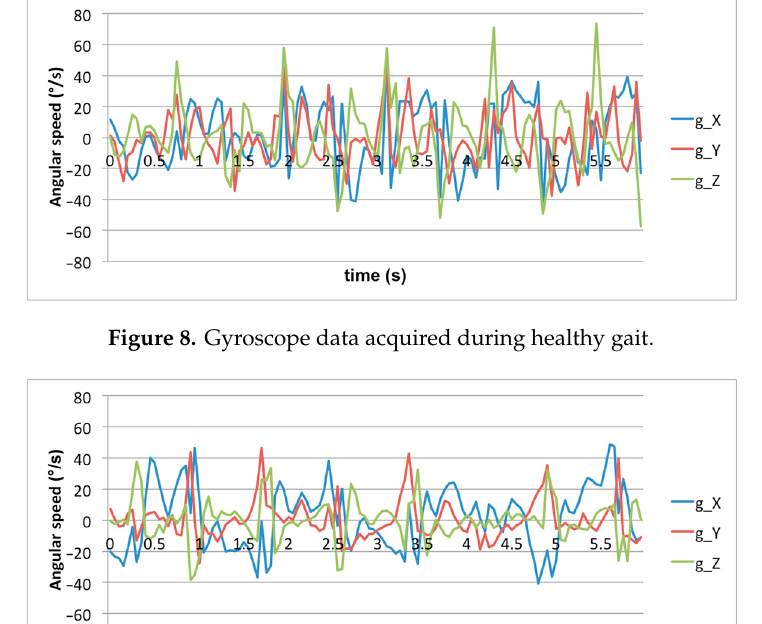
Figure 9. Gyroscope data acquired during shuffling gait.